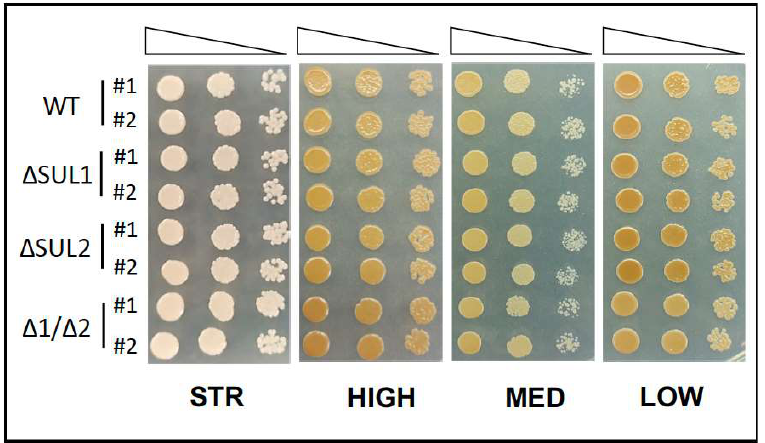
Figure 4. Sulphide (H 2 S) production of the winery yeast strains. As in Figure 1, the STR, HIGH, MED, and LOW yeast strains, either parental (WT) or isogenic mutants ( ΔSUL1, ΔSUL2 , and Δ1/Δ2 ), were spotted in H 2 S-sensitive medium (BiGGY) to assay sulphide release, as the colour intensity of colonies is related to the levels of H 2 S production. Images are representative of two independent experiments.